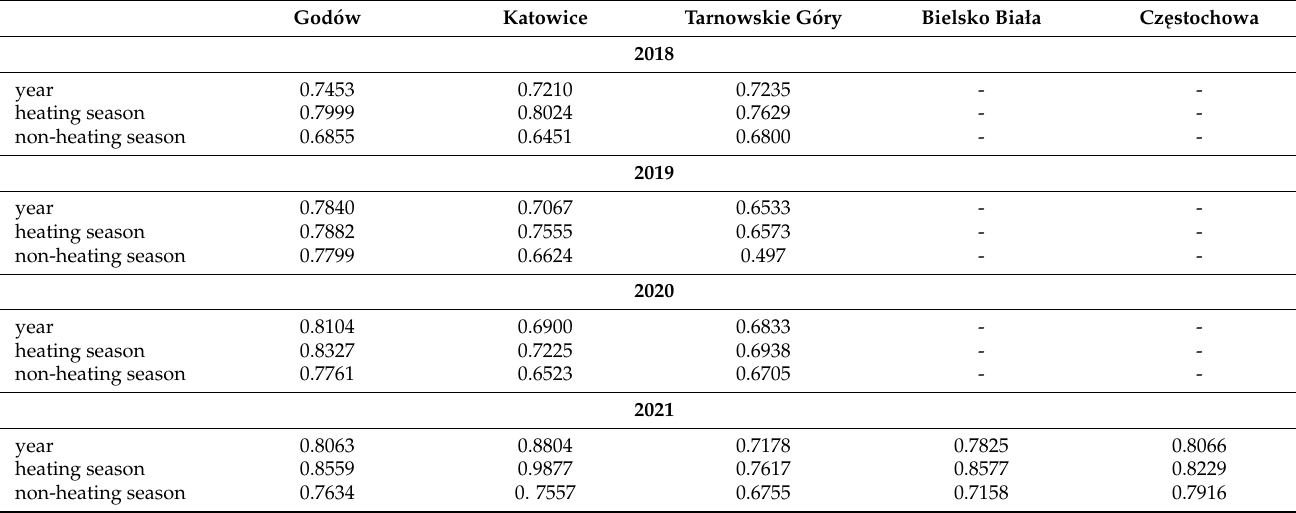
Table 1. The PM2.5/PM10 ratio in the period of 2018–2021 by heating and non-heating seasons. God ó